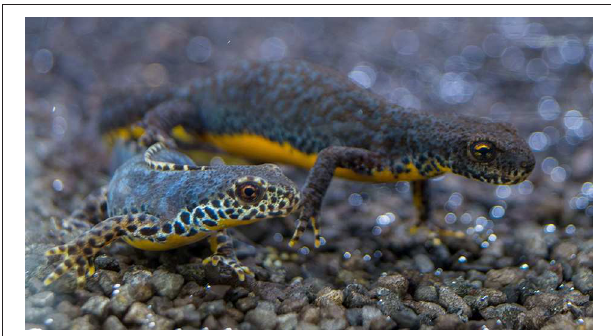
FIGURE 1 | Male (left) and female (right) Alpine newt, Ichthyosaura alpestris .